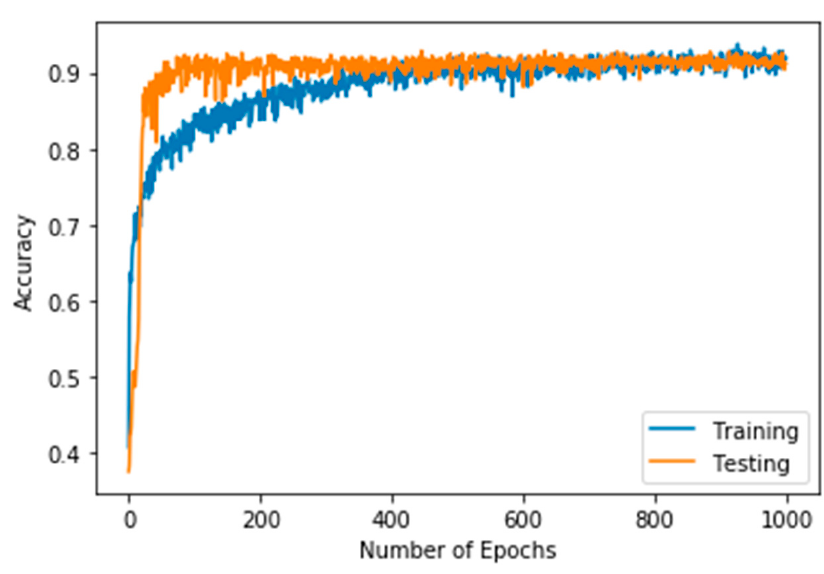
Figure 9. Loss curve for training and testing phases.